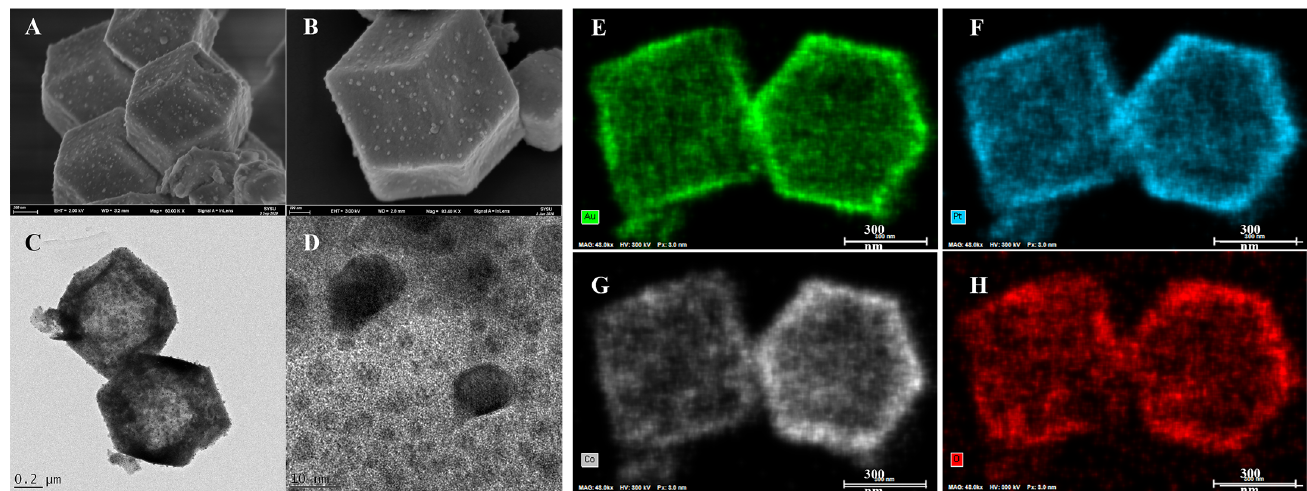
Figure 2. SEM ( A , B ) and TEM ( C , D ) images of Pt/Au NPs@Co 3 O 4 ; Au ( E ), Pt ( F ), Co ( G ) and O ( H ) element mapping for Pt/Au NPs/Co 3 O 4.